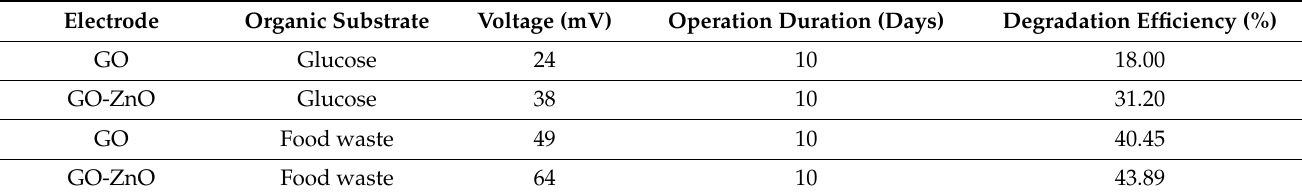
Table 5. Performance of commercial glucose and food waste as an organic